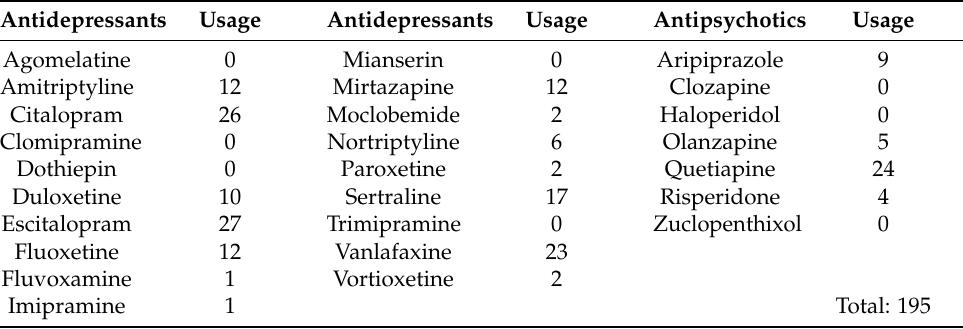
Table 1. Study compounds. Patients had to be currently taking at least one of the medications in the table to be included in the study. Included are usage frequency of each drug. Some patients were taking multiple